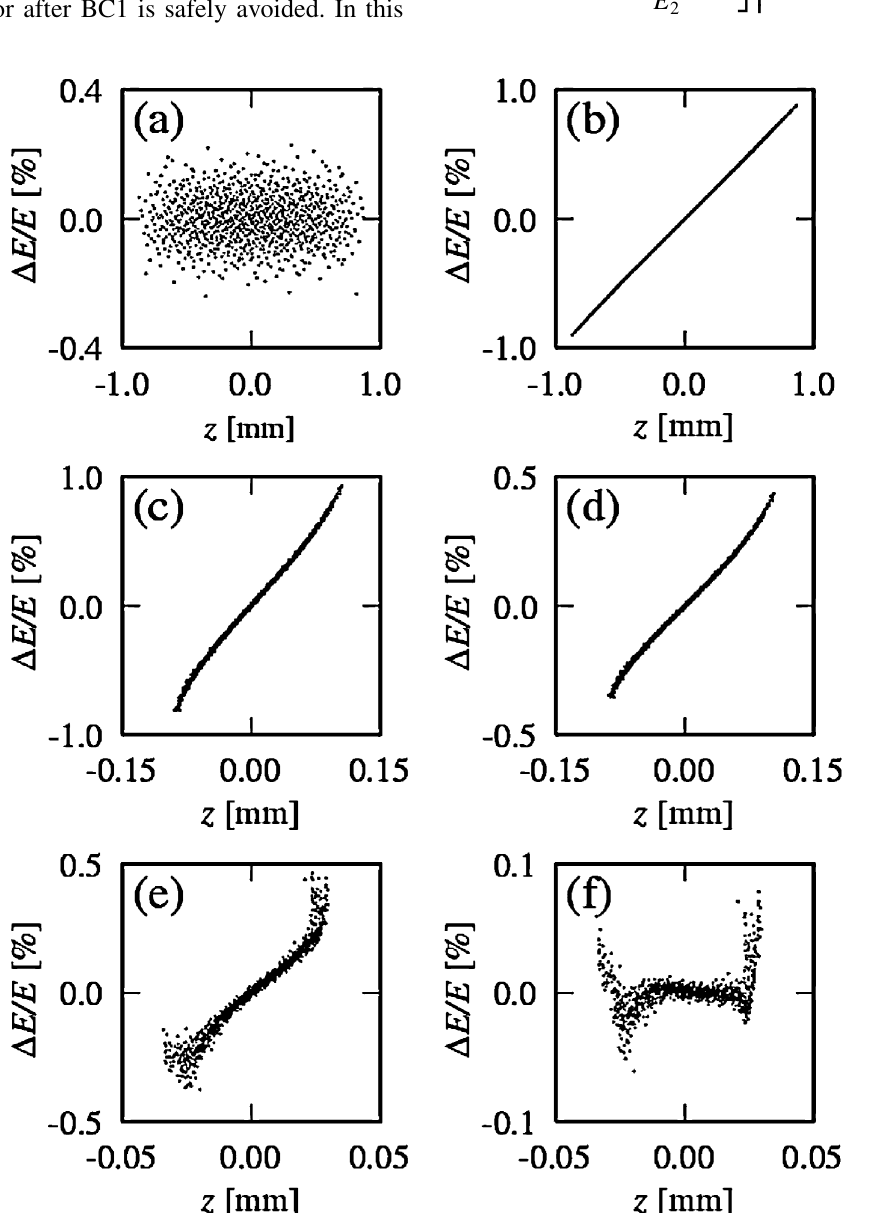
FIG. 8. Bunch compression for an initial parabolic current distribution with rms length of 400 (cid:2) m and charge of 200 pC. The longitudinal phase space evolution is given by ELEGANT simulations of 100 000 particles that include the coherent-radiation wakes of both chicanes in addition to the geometric wakes of the injector, harmonic cavities, L1 and L2 linacs. (a) Initial bunch at 4 MeV. (b) Chirped bunch at the entrance of the BC1 chicane. (c) Bunch after single-stage compression in BC1. (d) Chirped bunch at the entrance of the BC2 chicane. (e) Bunch after full compression in BC2. (f) Dechirped bunch at 1.7